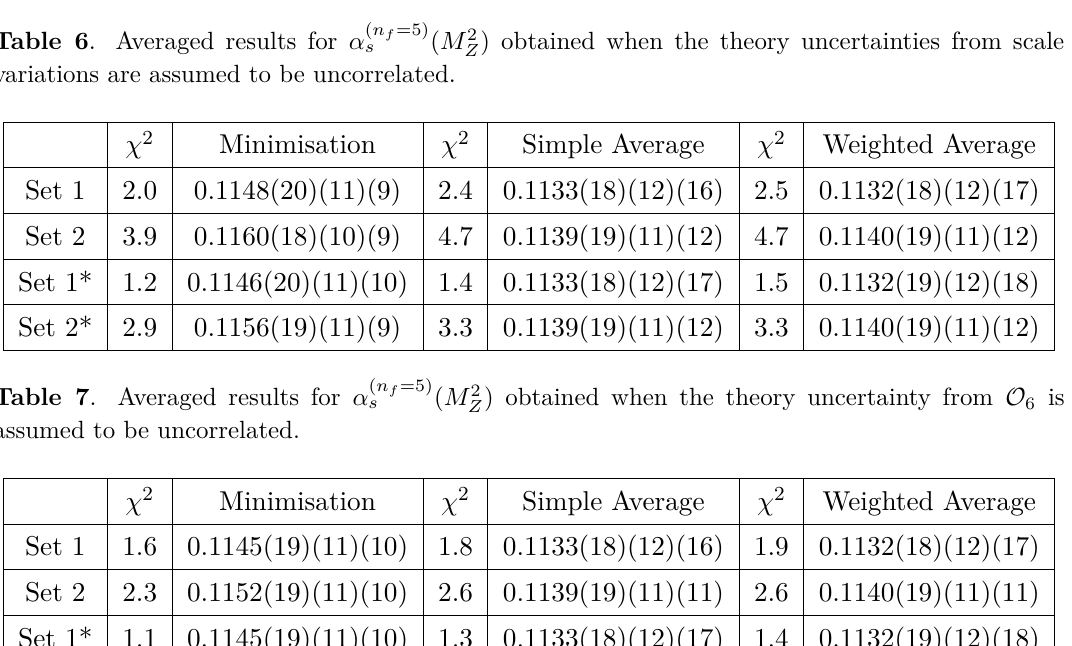
) obtained when the theory uncertainties from scale Z